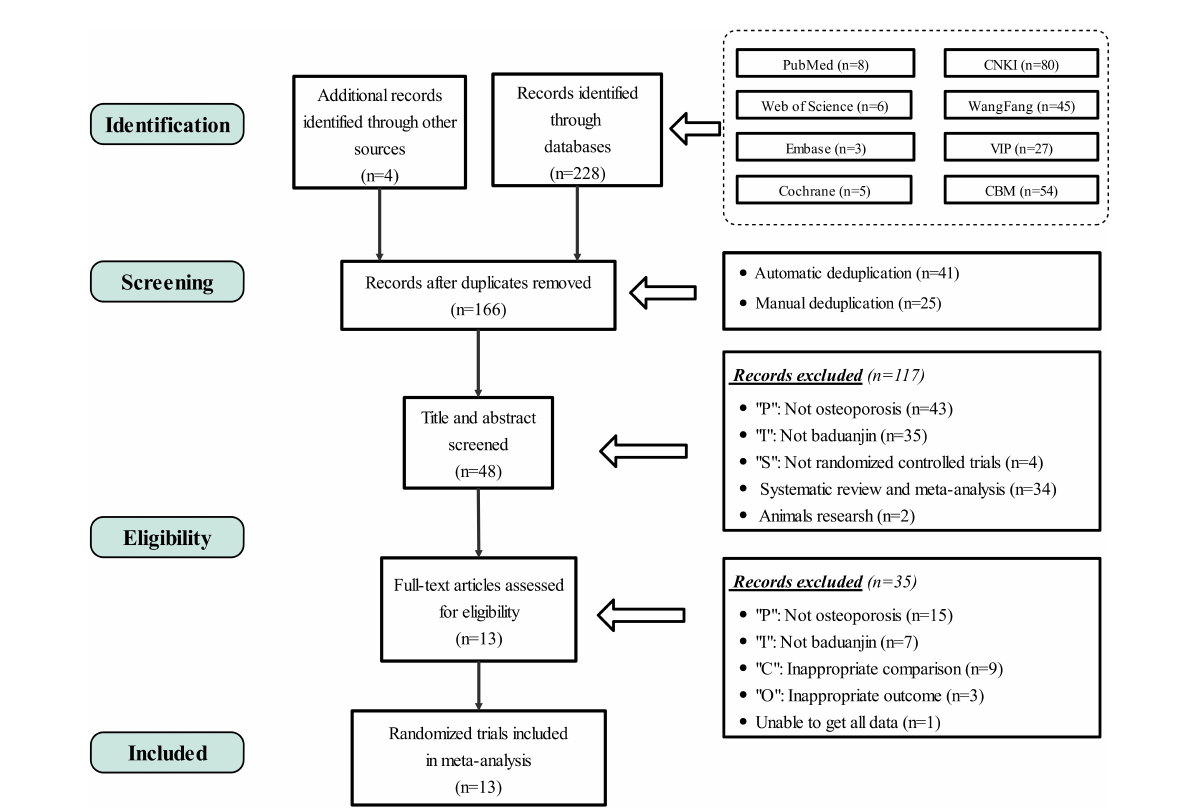
FIGURE1 PRISMA flow diagram. PRISMA, preferred reporting items for systematic review and meta-analysis; RCTs, randomized controlled trials; P, population; I, intervention; C, comparison; O,